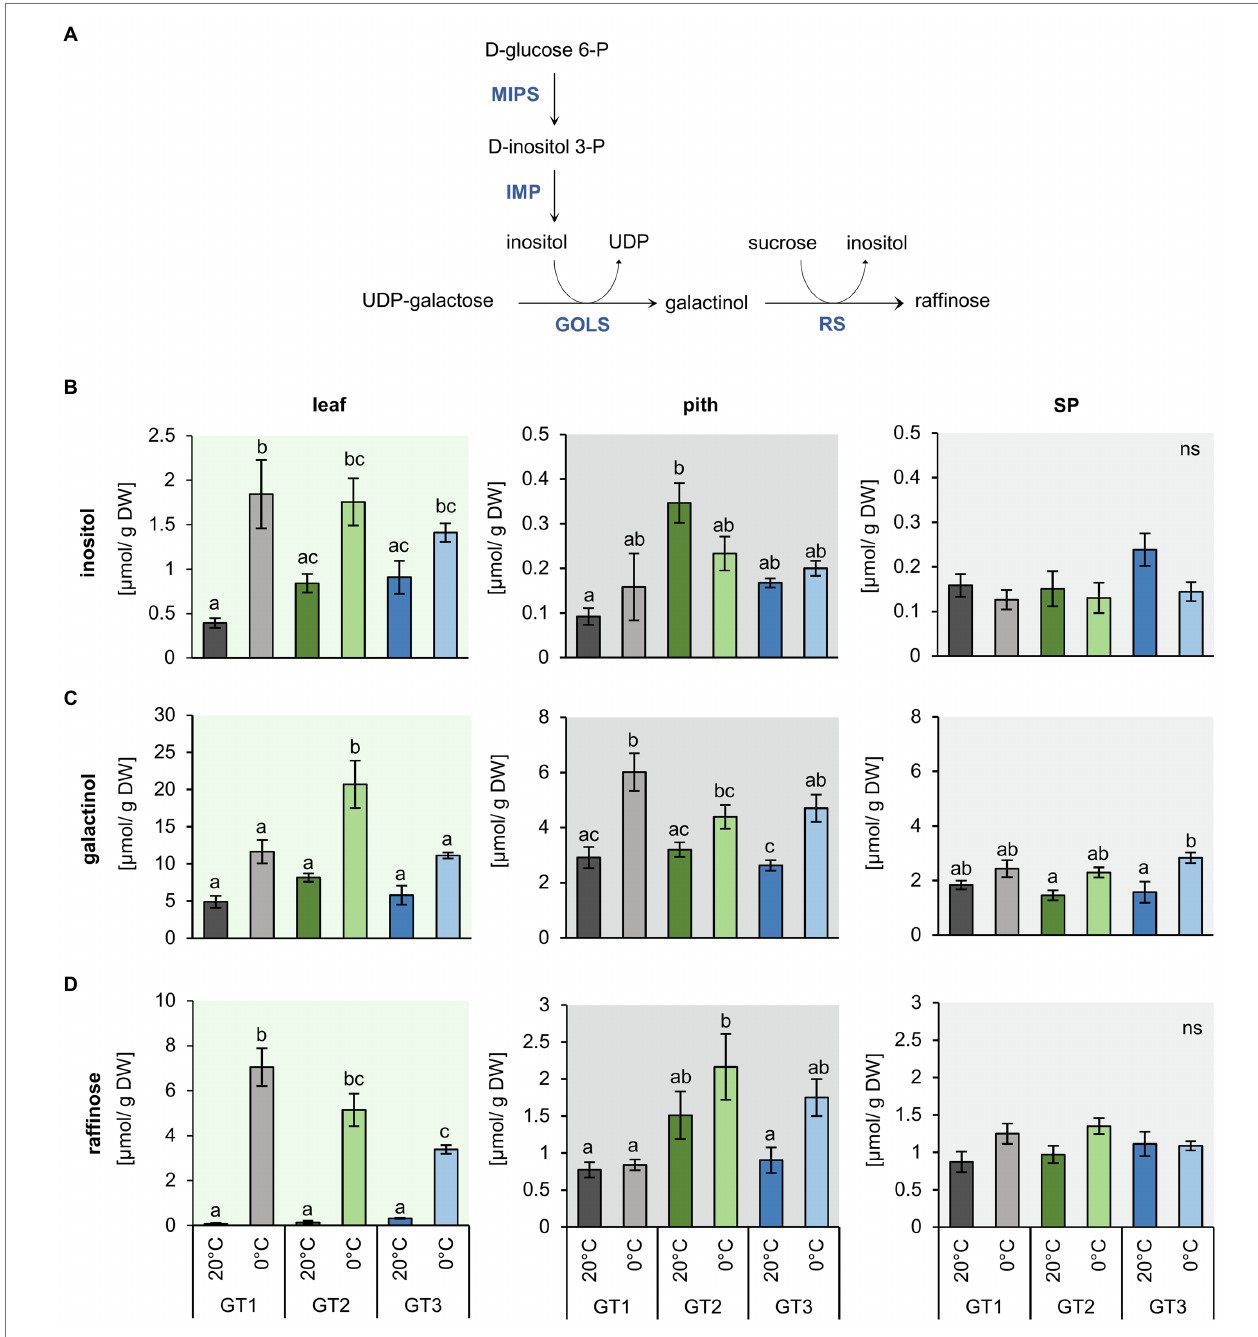
FIGURE 4 | Inositol and raffinose synthesis and their concentrations in leaf, pith, and storage parenchyma tissue under control and freezing temperatures. (A) Schematic representation of inositol and raffinose synthesis in plants. (B) to (D) Raffinose and intermediates in raffinose synthesis were measured in plants grown at 20 ° C and plants transferred to 12 ° C, 4 ° C and harvested at 0 ° C soil temperature. Plants were dissected in the three different tissues leaf, pith, and root while harvesting at the corresponding temperatures. Inositol (B) , galactinol (C), and raffinose (D) concentrations represent the mean of four biological replications for each of the tested cultivars. Error bars represent the standard error over the corresponding mean. Letters indicate the same level of significance for each measured concentration, calculated via two-way ANOVA with post-hoc Tukey HSD testing with p <